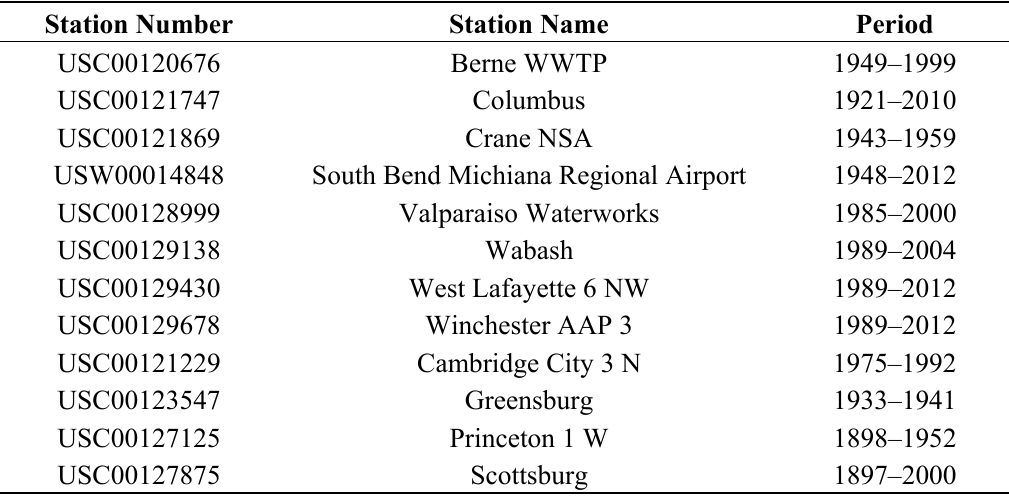
Table 1. Daily precipitation collection from National Climate Data Center (NCDC).